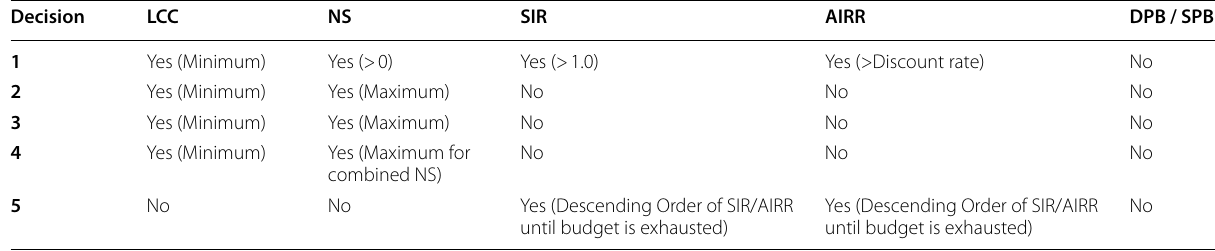
Table 1 Suitability of different measures for different decisions outlined in Decisions related to economic feasibility section Decision